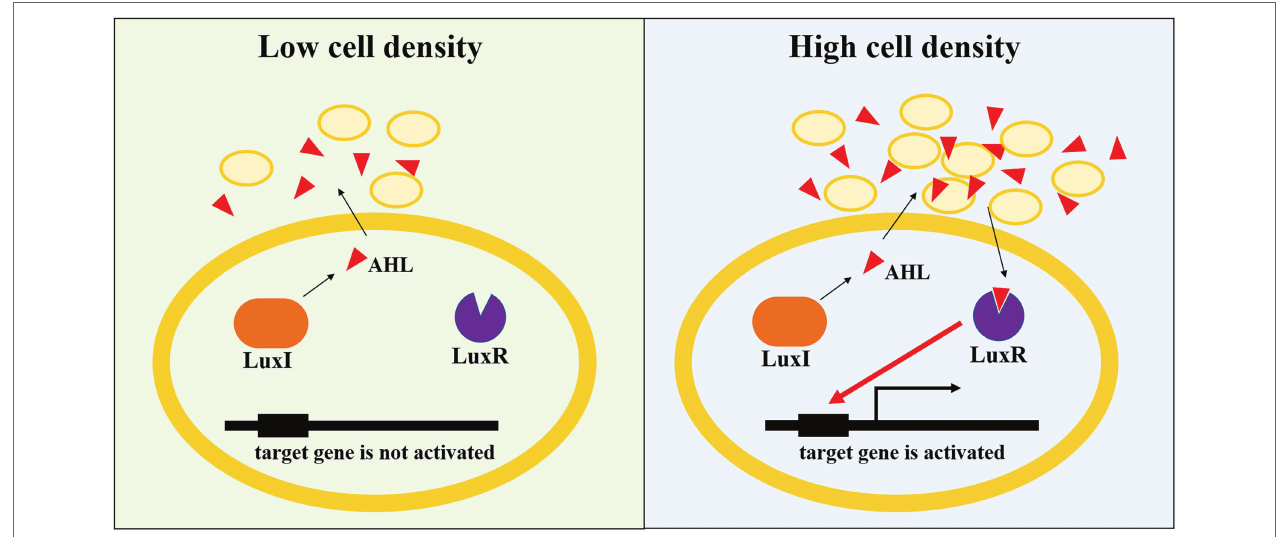
FIGURE 2 | Schematic of AHL-mediated QS in gene express regulation.